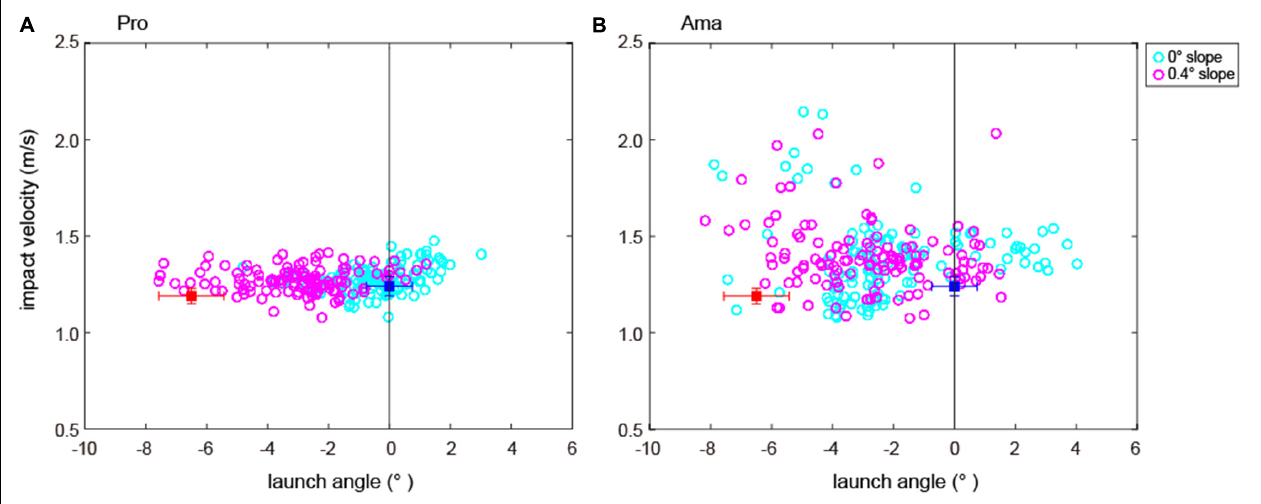
FIGURE 8 | Relations between the impact velocity and launch angle of all participants’ trials and hole-in trials. (A,B) The plots of all trials (240 trials) involving ball launch angle and impact velocity for the 12 people in each group. The red and blue squares show the average and SD ( ± 1SD) of the hole-in trials in the 0.4- and 0-degree conditions, respectively. The red and blue squares in (A,B) have the same values (see also Table 3 for details regarding the hole-in trials).